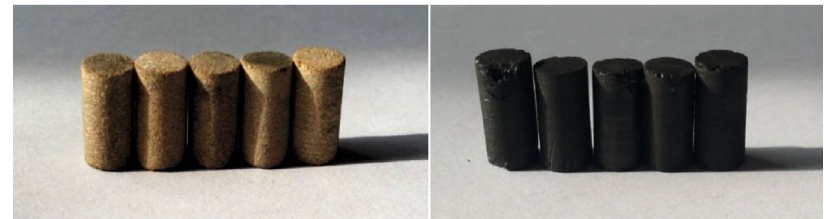
Figure 1: Yellow sandstone samples and coal